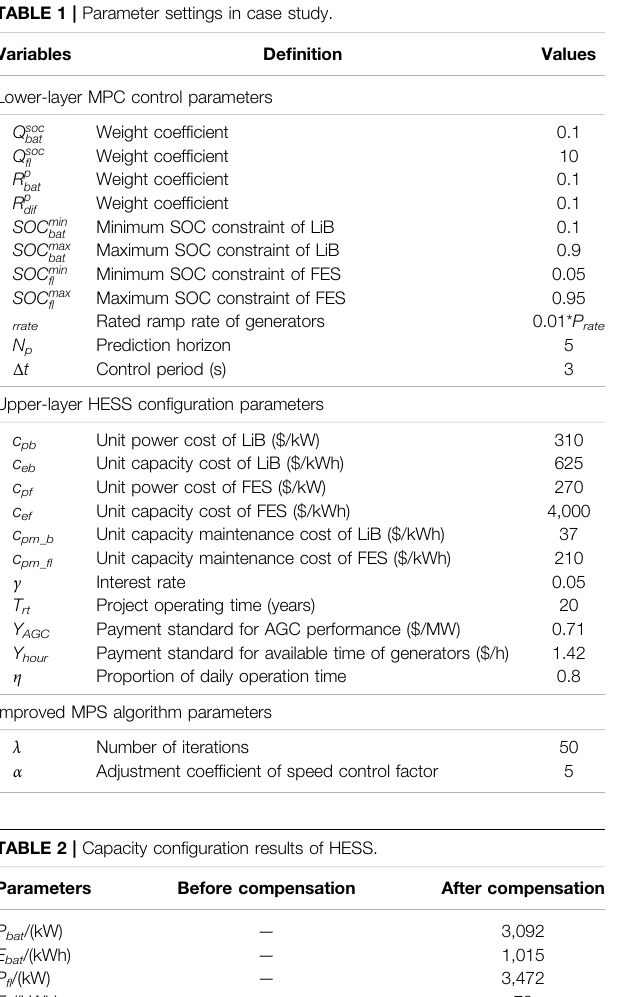
TABLE 1 | Parameter settings in case study.